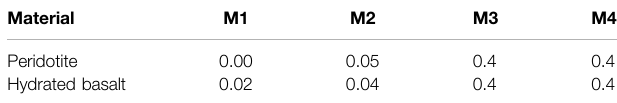
TABLE A1 | Melt extraction threshold values.